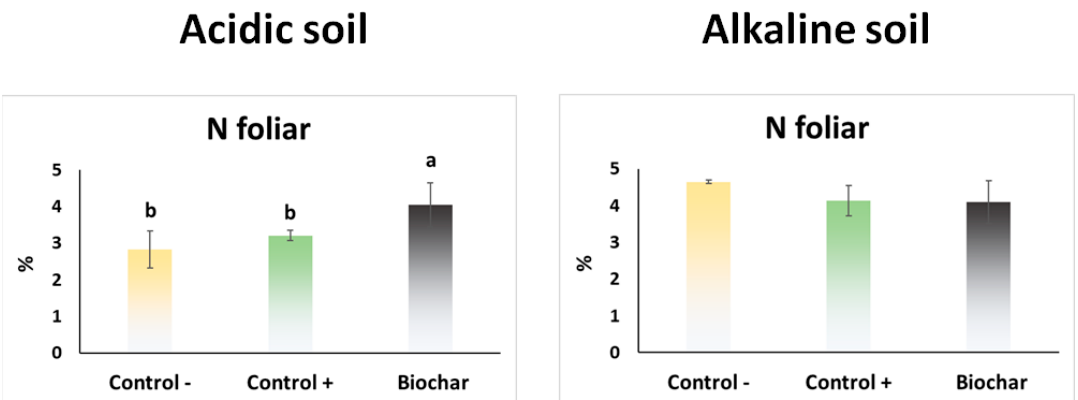
Figure 6. Tomato plant foliar N content in both acidic and alkaline soils. Control -, without Pi; Control +, with Pi and biochar, with Pi + biochar as an amendment. Different letters indicate significant differences among treatments.